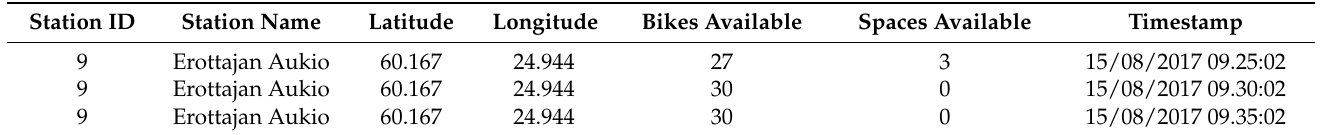
Table 2. Example of the station status data.